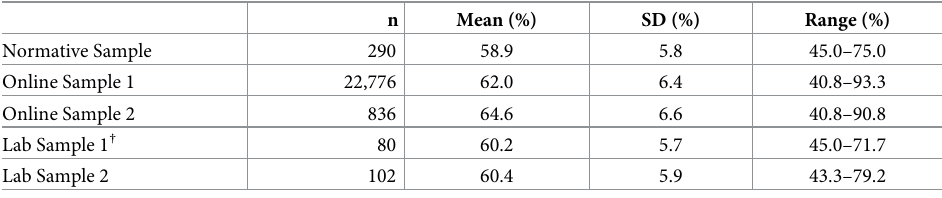
Table 1. Mean accuracy, standard deviations, and range of accuracy in each participant